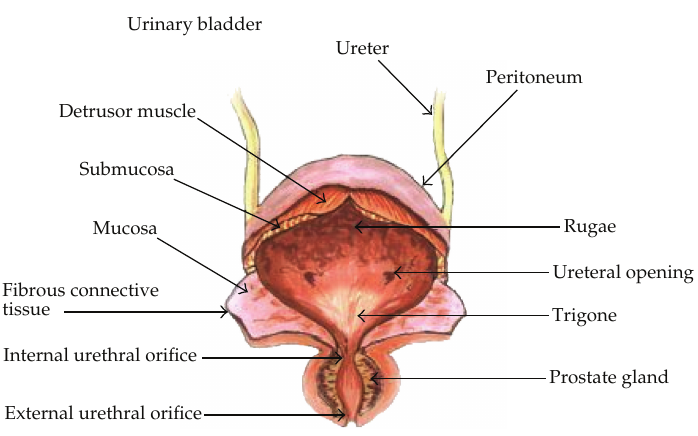
Figure 1: Diagram taken from (cid:3) 8 (cid:4) of sections through the urinary tract and more specifically the ureters, parts of the bladder and the